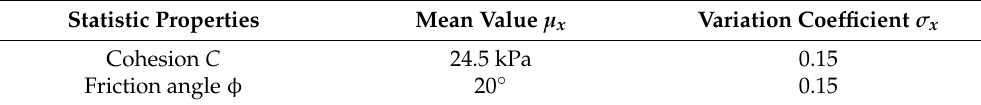
Table 2. Statistic properties for slope